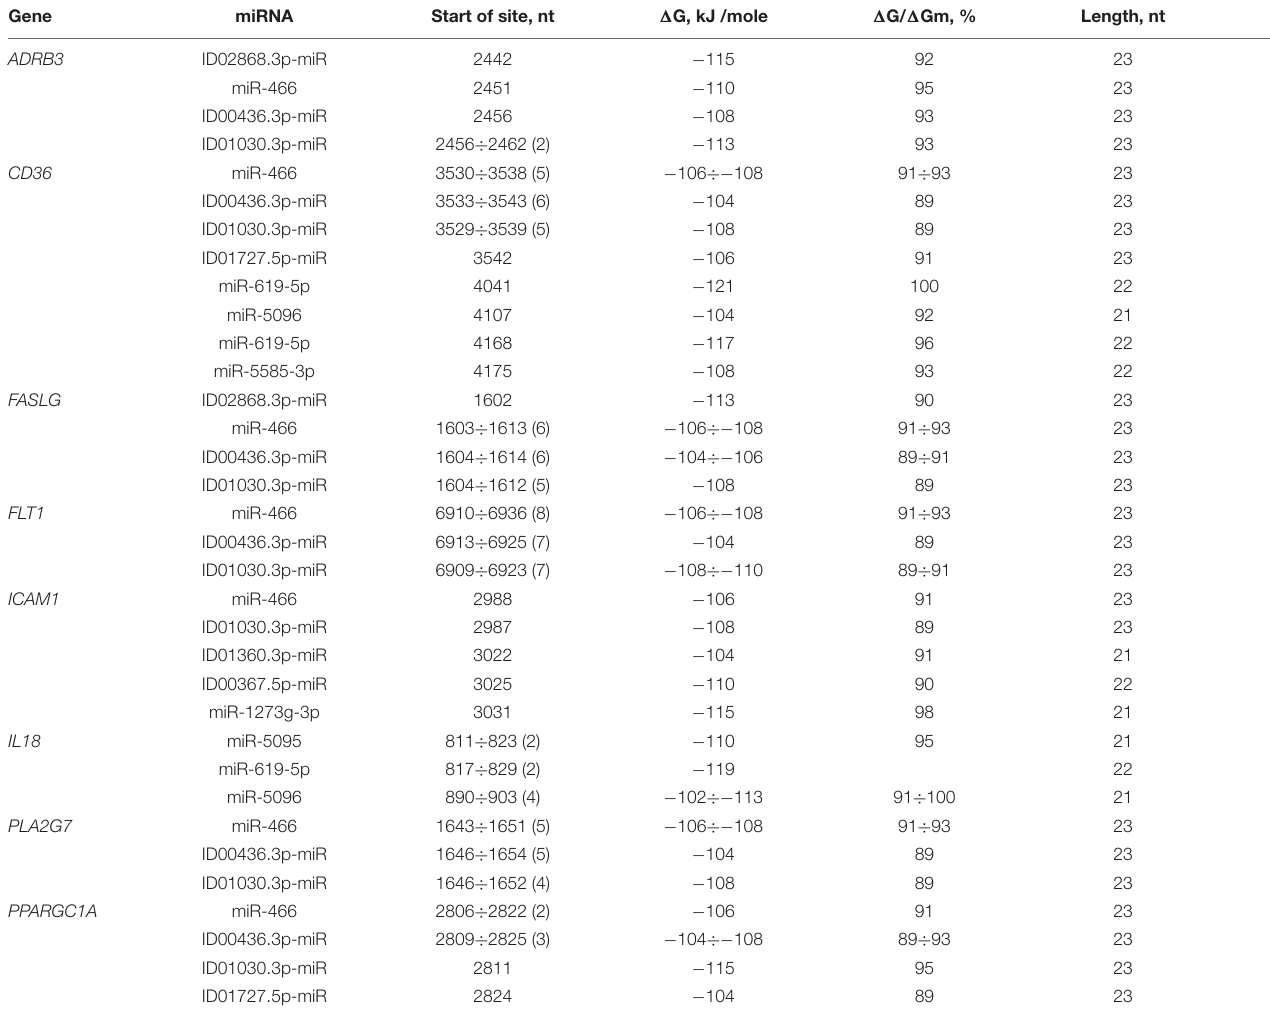
TABLE 3 | Characteristics of miRNAs interaction in the 3 (cid:48) UTR of mRNA of atherosclerosis candidate genes.